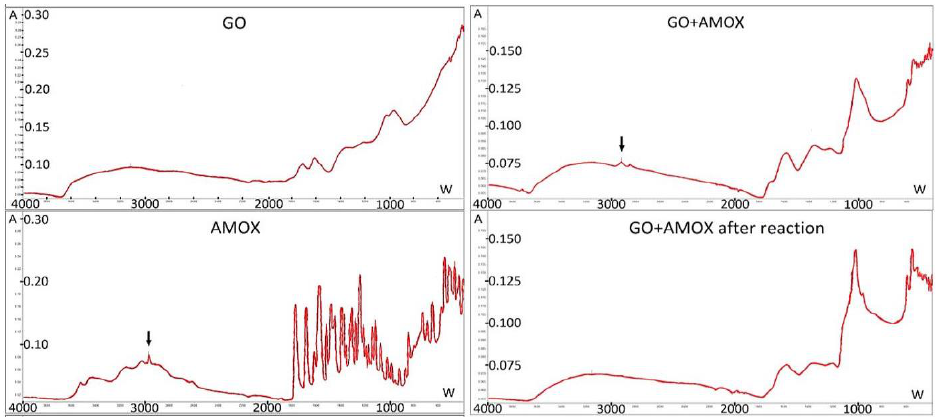
Figure 3. FT-IR spectra of AMOX, GO, GO with AMOX attached, and GO-AMOX after enzymatic reaction (C E = 0.2 mg/mL, 72 h). A—absorbance, W—wavenumbers [cm − 1 ].